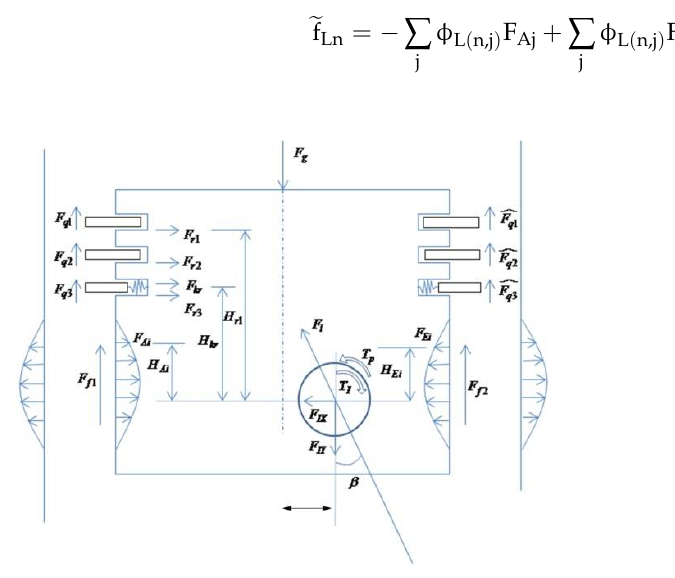
Figure 1. Schematic of force diagram of the piston.